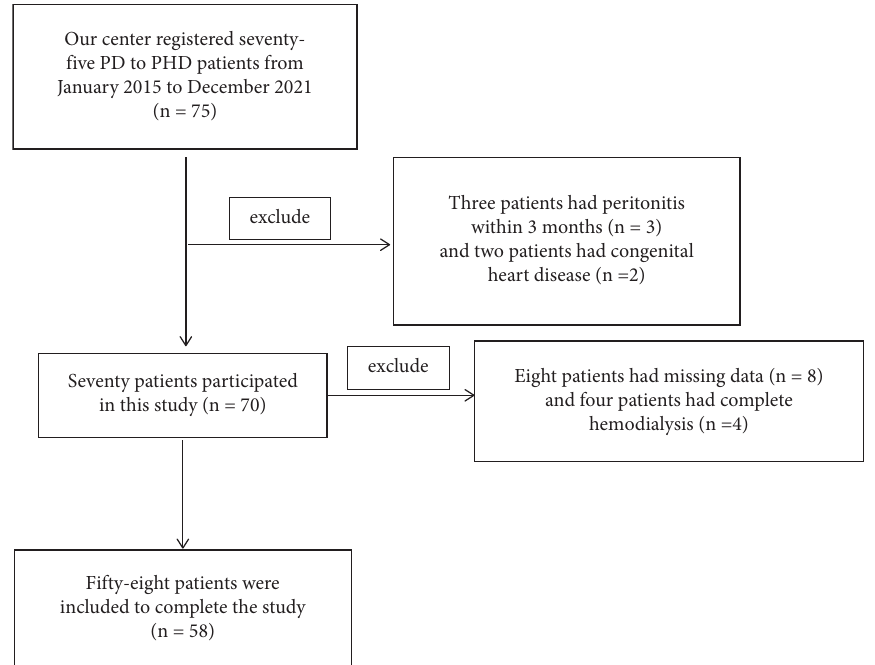
Figure 1: Te experimental fow